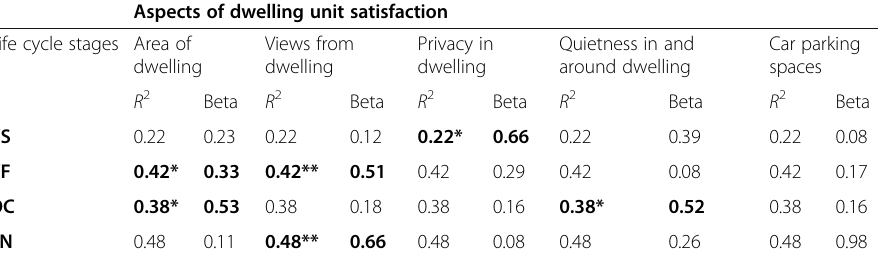
Table 6 Regression analysis results for dwelling unit